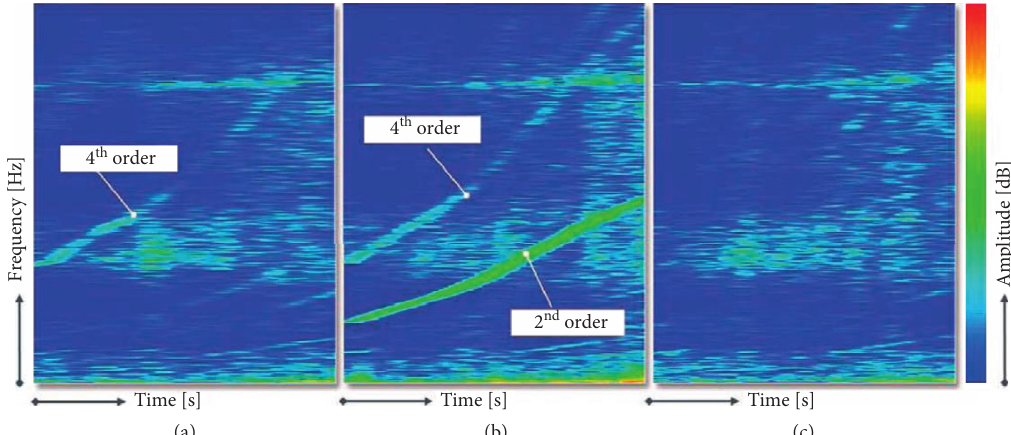
Figure 1: Vibration results of 8-cylinder mode and 4-cylinder mode in driving mode with AEM off or on [5]: (a) 8-cylinder mode; (b) 4- cylinder mode; (c) 4-cylinder mode AEM